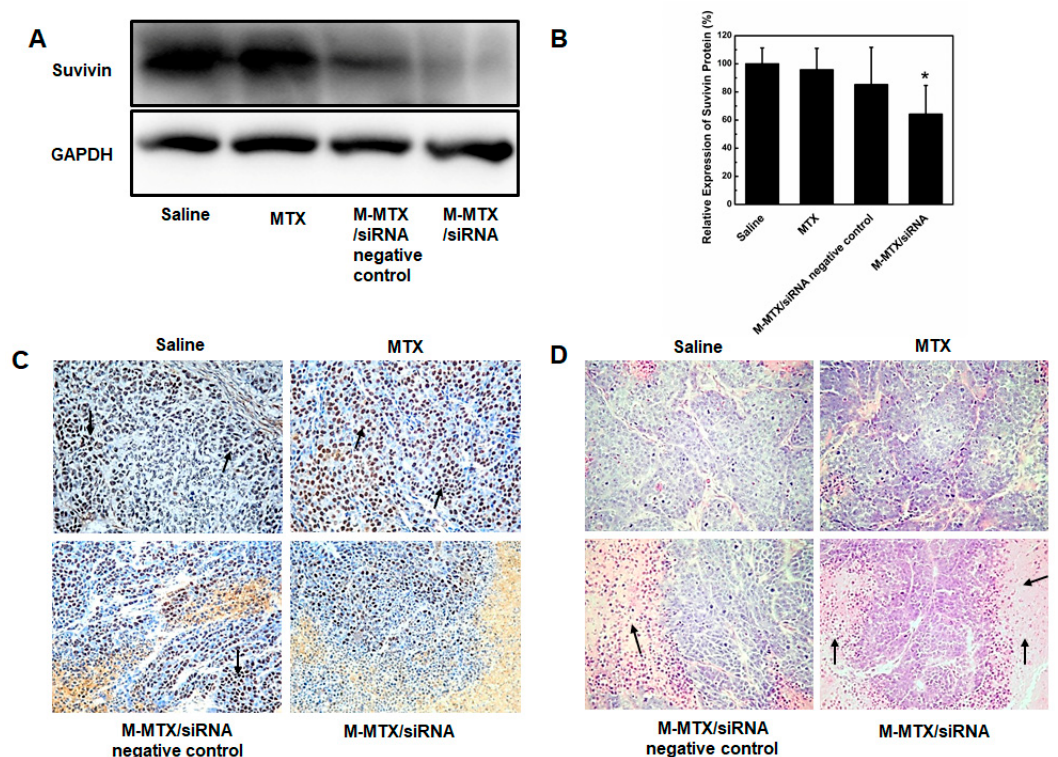
Figure 7. The protein expression, immunohistochemistry, and histopathological analysis of tumor tissues. Survivin expression in tumor tissue was determined by western blot assay ( A ) and then quantified by image J ( B ) (n = 3, *P < 0.05, M-MTX/siRNA compared to saline). The immunohistochemical analysis of protein expression ( C ) and the hematoxylin-eosin staining for tumor tissue necrosis ( D ) was also investigated.